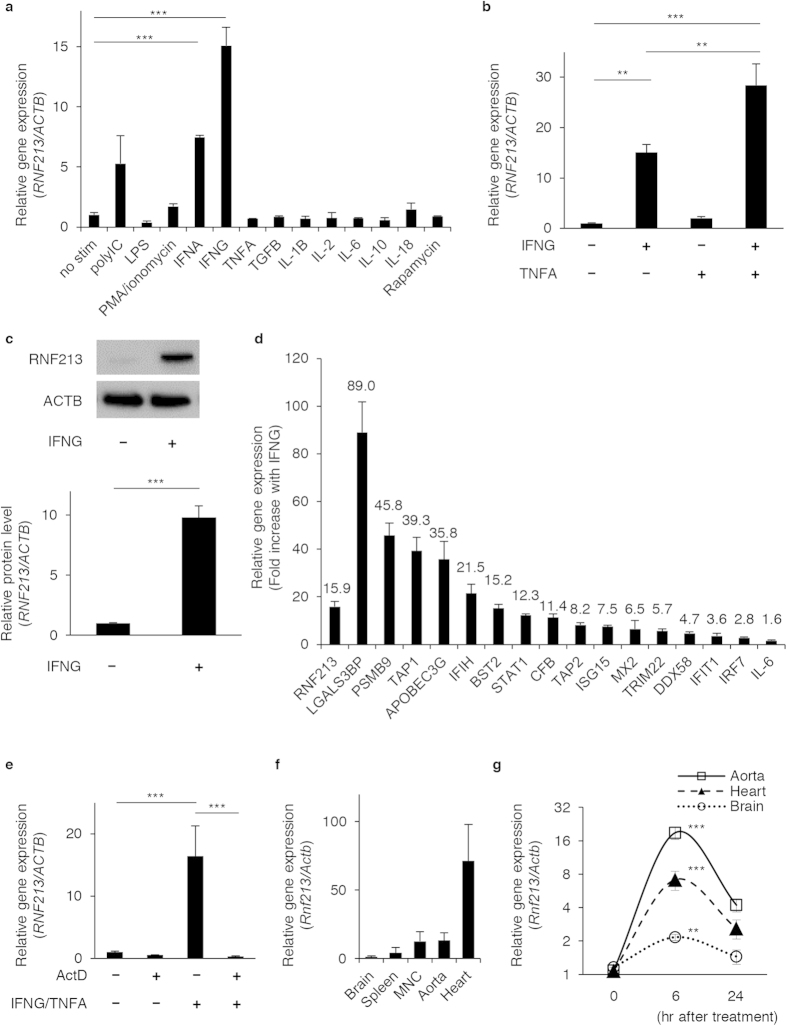
RNF213 is transcriptionally activated by IFNG and TNFA in vitro and in vivo. (a) Relative expressions of RNF213 in HUVECs when stimulated with various ligands for innate immunity and cytokines in comparison to that of control (“No Stim”). (b) Synergistic effects of IFNG and TNFA treatments on RNF213 expression in HUVECs. (c) Western blot analysis for the RNF213 protein induction with IFNG treatments in HUVECs. Quantified results are plotted under the blotting image. (d) Coinstantaneous inductions of RNF213 and other co-expressed genes upon IFNG treatments of HUVECs. (e) Suppression of RNF213 induction after IFNG and TNFA treatments by actinomycin D (ActD) for HUVECs. (f) The steady-state Rnf213 expressions in various tissues of female mice at 4-weeks of age (compared with Brain). (g) Acute induction of Rnf213 transcripts after intraperitoneal injections of IFNG and TNFA in vivo. (a–g) Data are shown as mean ± SD values from 3 or more independent assays and analyzed using Dunnett’s test (a,g) Tukey’s HSD test (b,e) and Student’s t-test (c). **p < 0.01, ***p < 0.001.